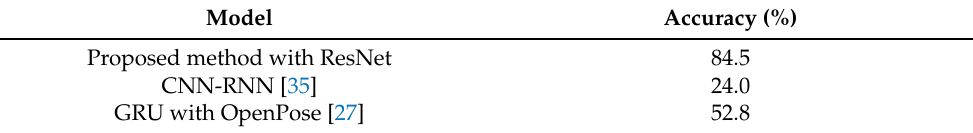
Table 4. Comparison of training accuracy of the proposed method, CNN-RNN and GRU